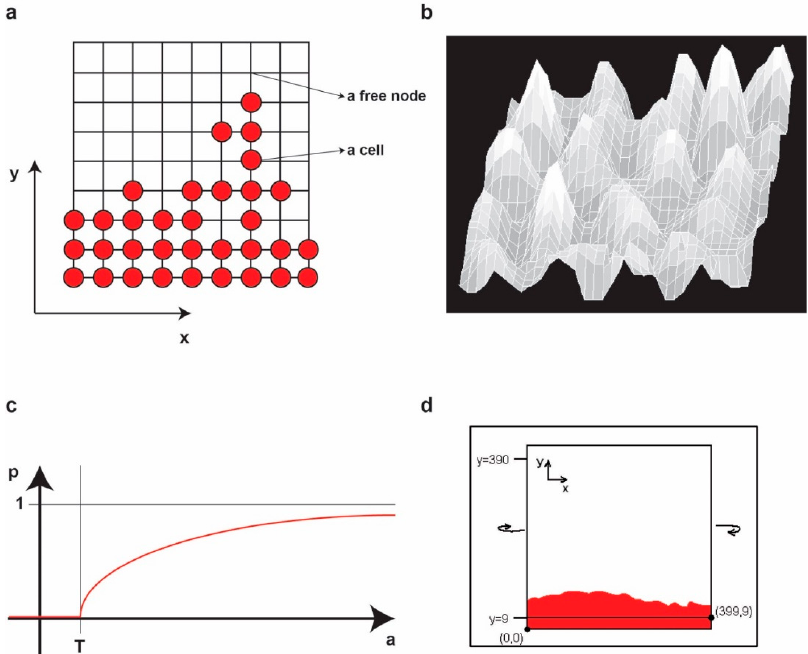
Figure 2. (a) An example of a small grid configuration. To each node ( x, y ) (either free or occupied) we associate the concentrations of a and h in ( x, y ). (b) An example of the ’landscape’ representation of the concentrations of a for some parameters at some moment in time. Higher values correspond to higher peaks. (c) The graph of p(a) . (d) The evolution of the populations of cells from the initial population inside the [0,0] - [399,9] box.